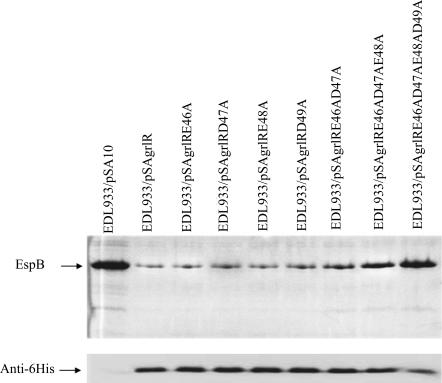
General Secretion Profile of EHEC EDL933 Harboring pSA10-grlR and Expressing Wild-Type and Mutants of GrlRSecreted proteins were concentrated from supernatants of bacterial culture grown in DMEM and resolved in 12% SDS-PAGE and stained with coomassie brilliant blue (upper panel). Western blot of EHEC total cell protein against 6His antibody (lower panel).